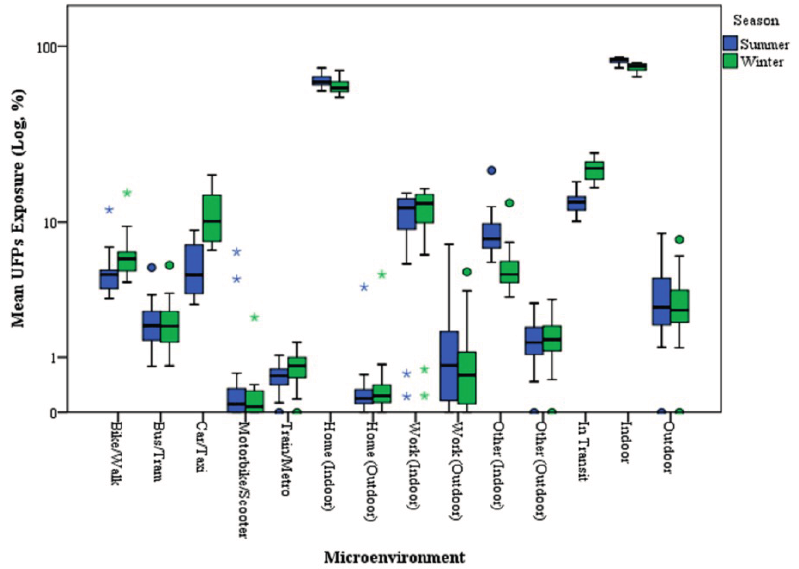
Figure 1. Box plots of calculated UFP exposures (%) estimated in indoor and outdoor microenvironments for summer and winter. The central box comprises values between the 25th and 75th percentiles, and the whiskers show the range of values that falls within 1.5 times the interquartile range beyond the box.